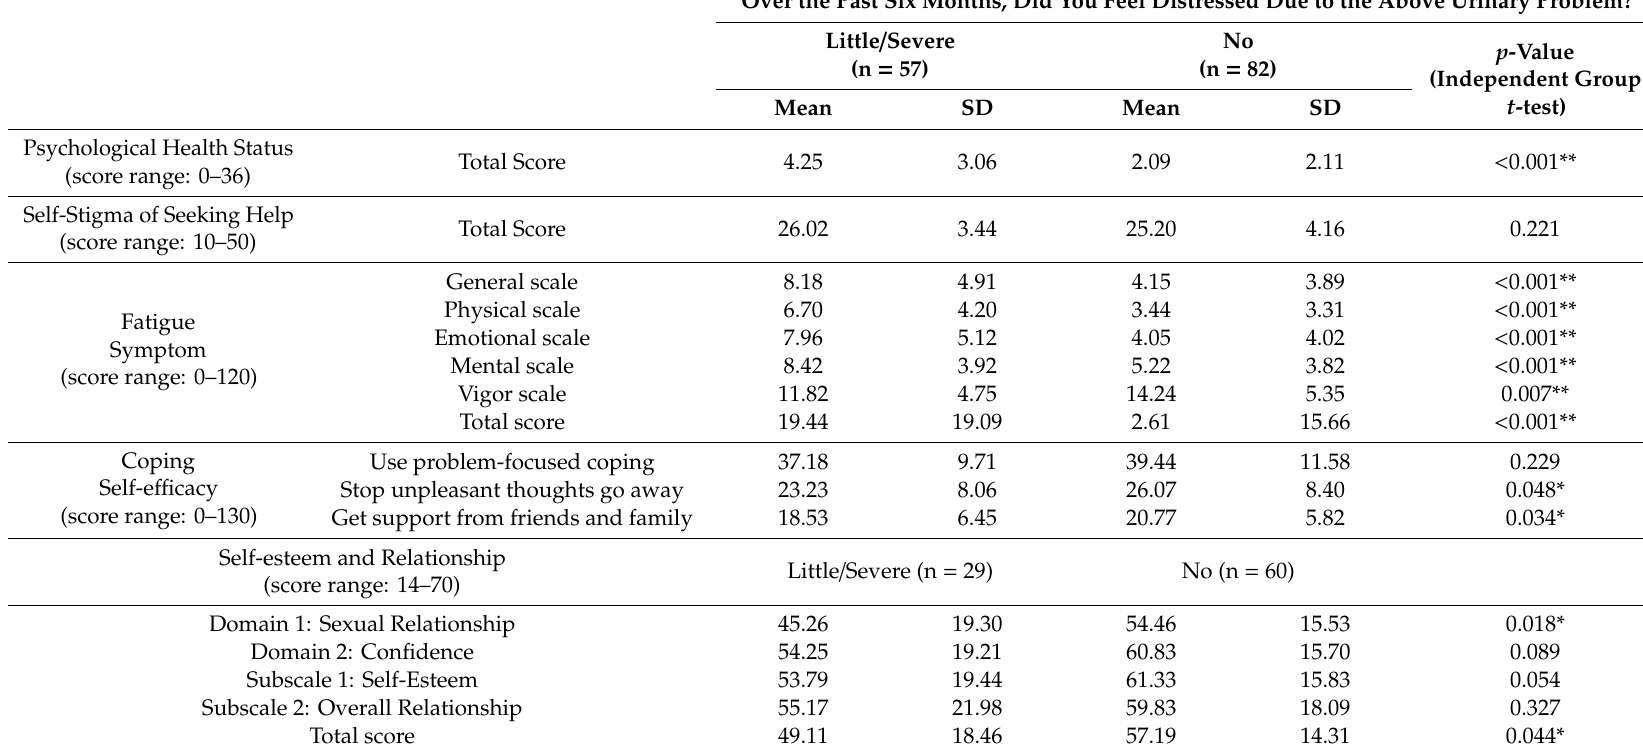
Table 3. Relationships between distress due to urinary problems and psychosocial status. Over the Past Six Months, Did You Feel Distressed Due to the Above Urinary